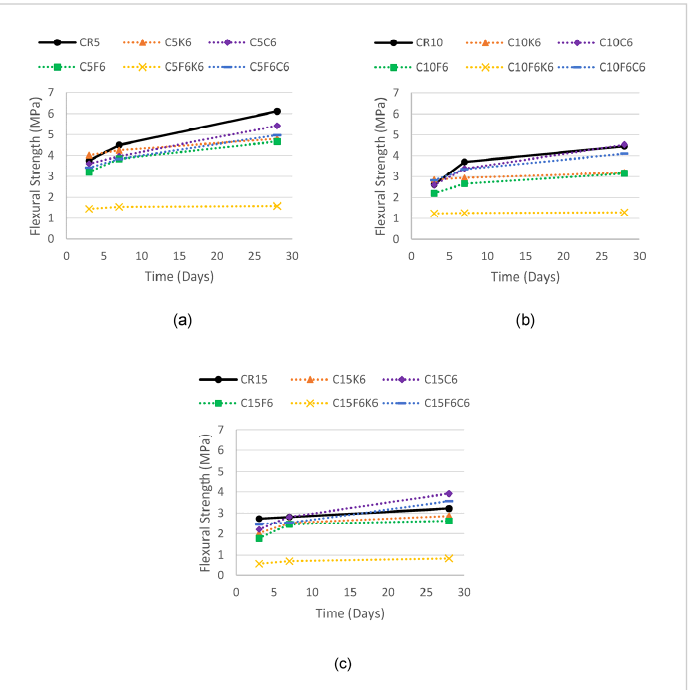
Figure 7. Flexural strength comparison for fiber-reinforced CRM at 3, 7, and 28 days. ( a ) 5% CR replacement. ( b ) 10% CR replacement. ( c ) 15% CR replacement.